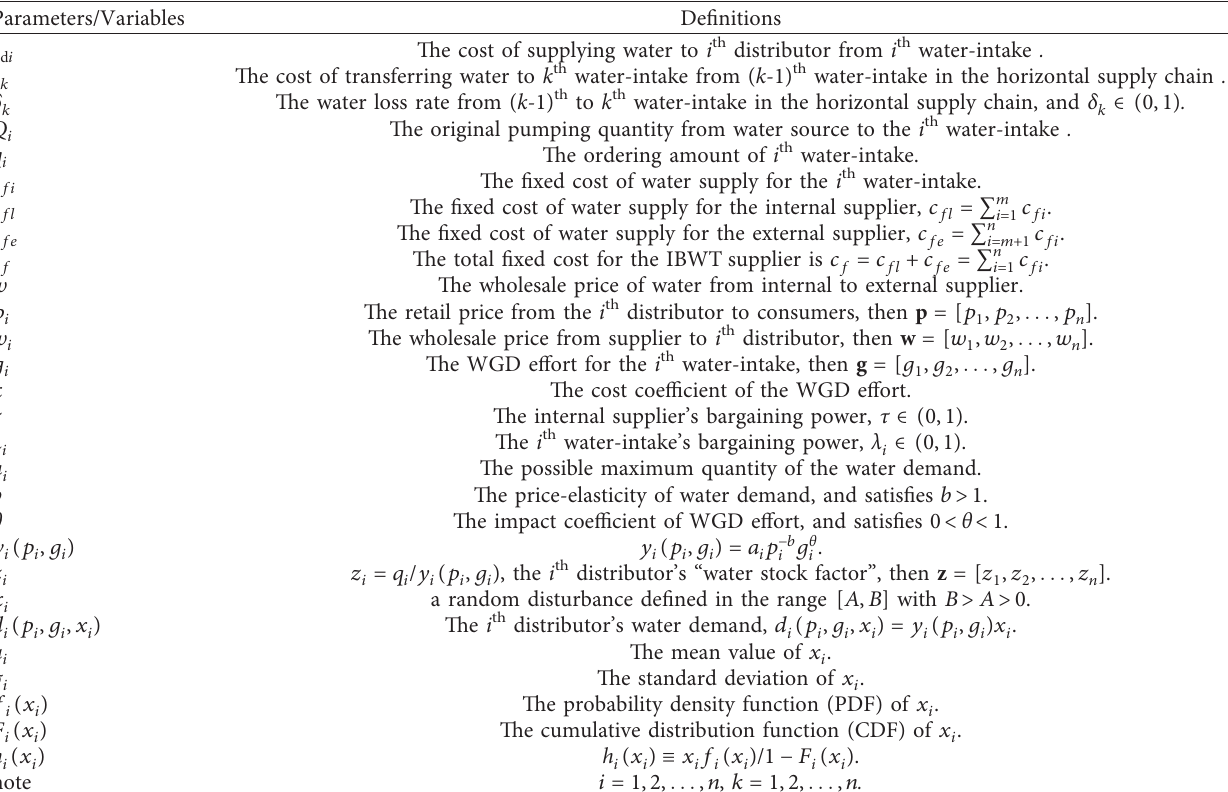
Table 1: Parameters/variables